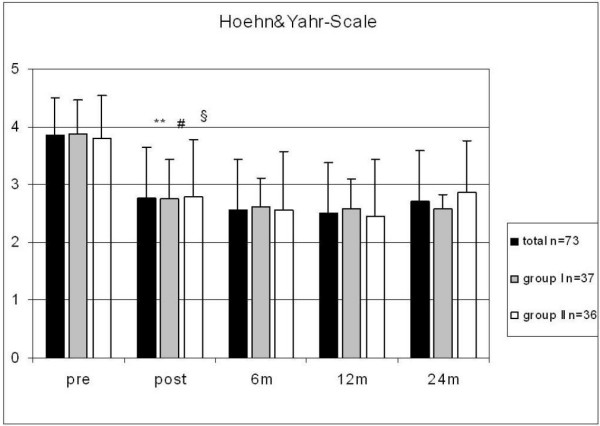
Hoehn and Yahr scores in all patients as well as in groups I and II preoperatively (with/without medication) and at follow-up after 6, 12, and 24 months; significant differences between pre- and postoperative scores in all groups (**, #, § p < 0.05).